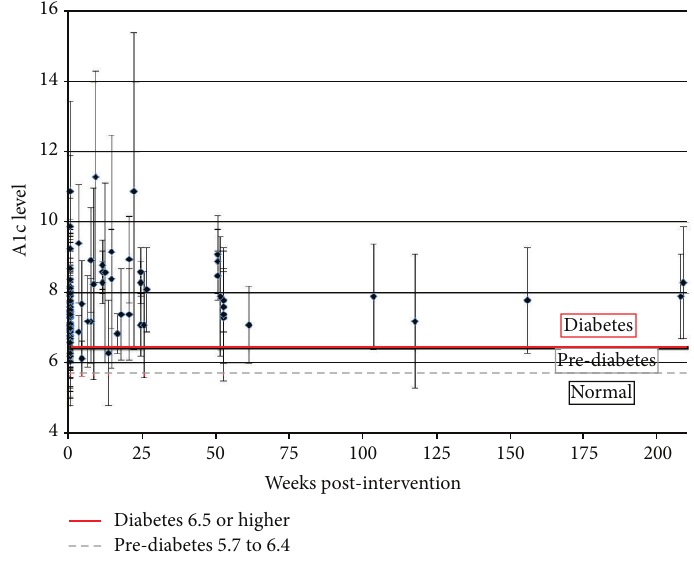
Figure 2: Post-intervention A1c levels